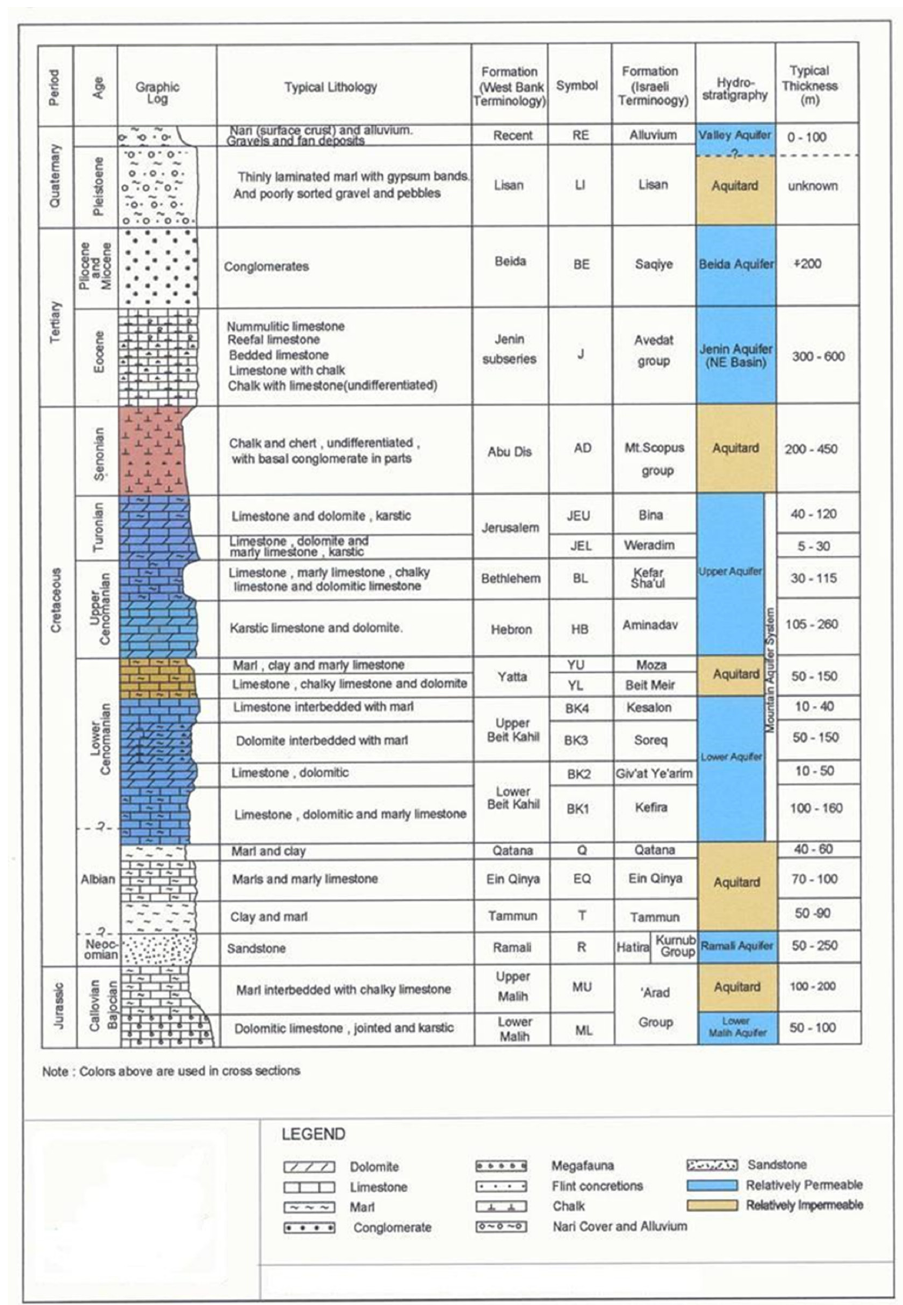
Figure 2. Hydro-stratigraphic section of the West